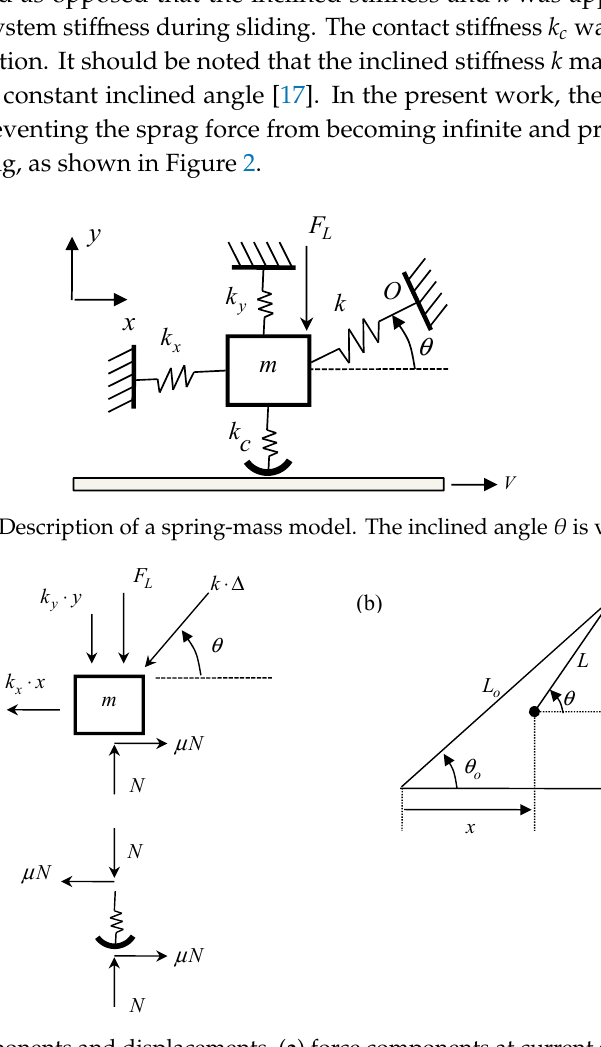
Figure 2. Force components and displacements, ( a ) force components at current state, ( b ) definition of deformation.